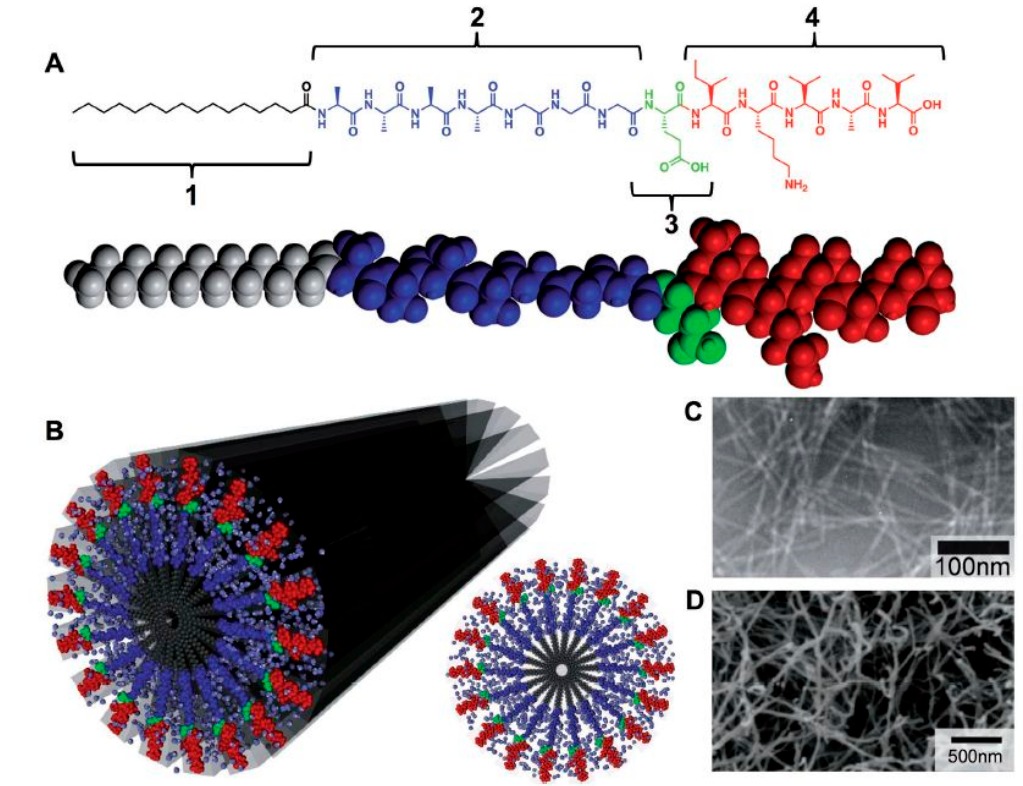
Figure 6. ( A ) Molecular structure of a peptide-amphiphile (PA) with four rationally designed chemical entities. ( B ) Molecular graphic illustration of the PA molecule and its self-assembly into nanofibers in addition to a schematic of the cross-section of these fibers ( C ) TEM images of isolucinelysine-valine- alanine-valine (IKVAV) nanofibers and ( D ) SEM micrograph of an IKVAV nanofiber mesh— reproduced with permission from [82]. Copyright Wiley,